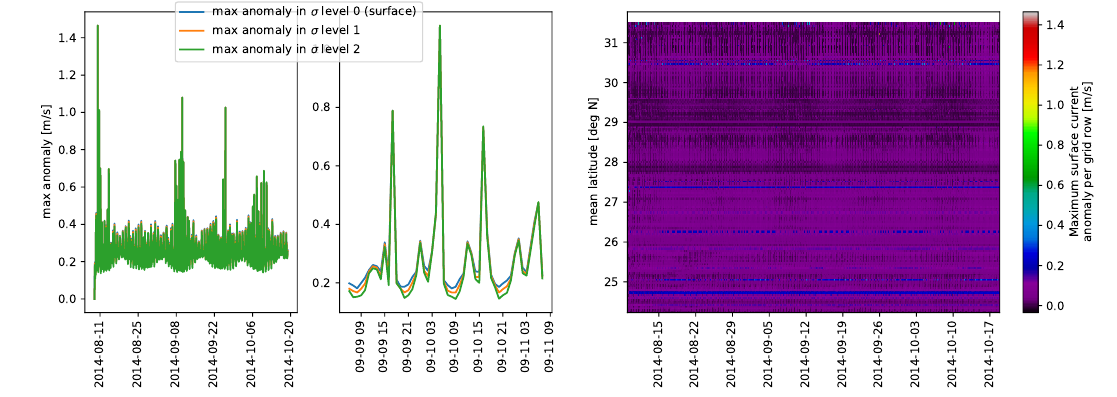
( b ) Time evolution of maximum anomaly per grid row.